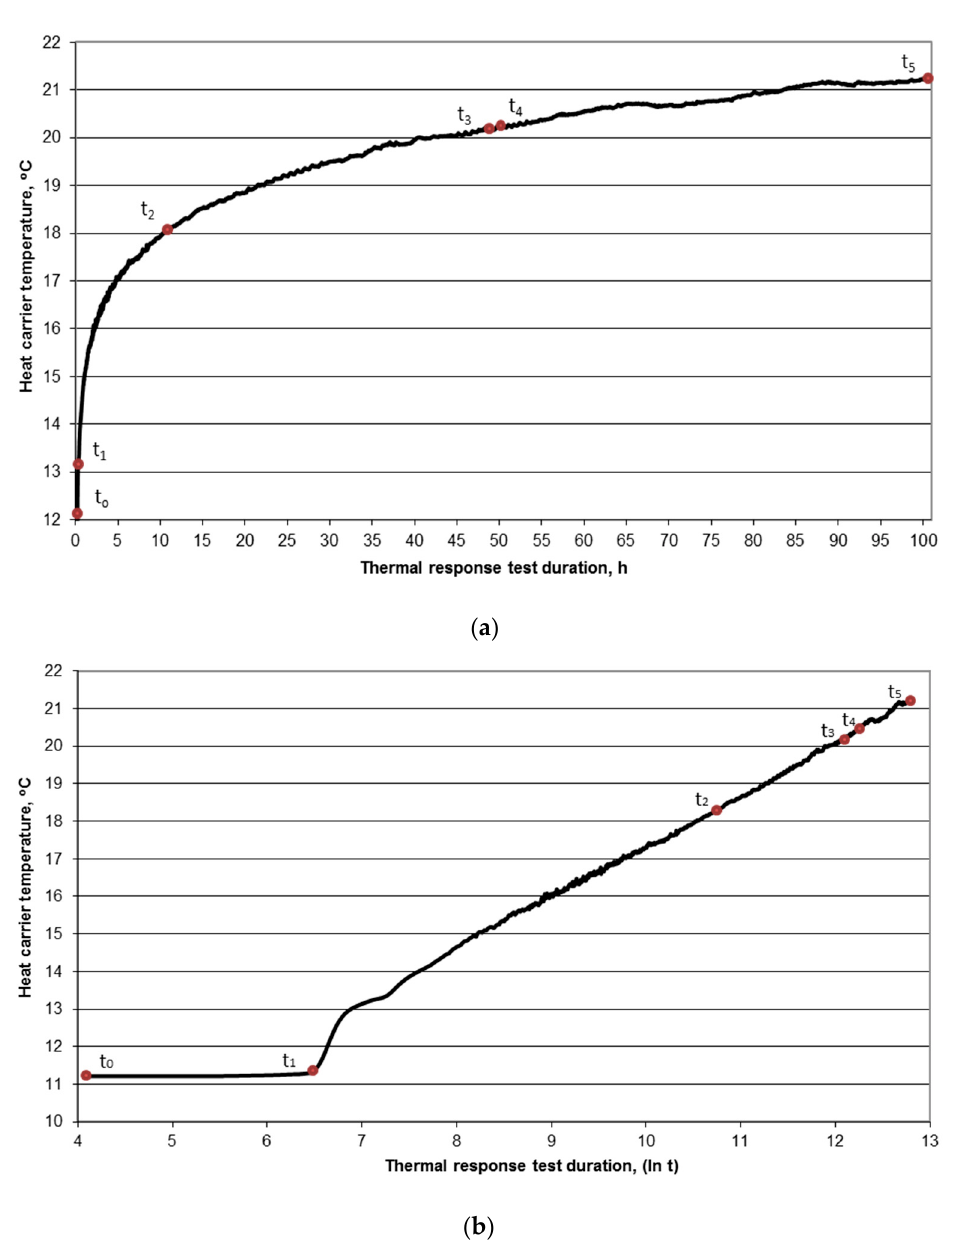
Figure 4. Variation of temperature of heat carrier flowing out of BHE with ( a ) time and ( b ) logarithm of time, showing key characteristic times.